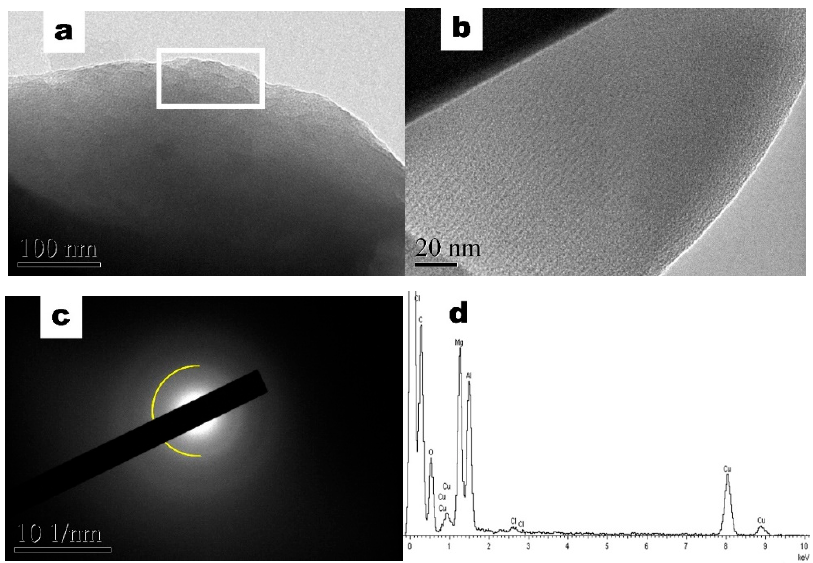
Figure 3. HR-TEM images of the as-prepared coating that is structured in nanolayers that overlap themselves ( a ), ( b ); ( c ) the SAED pattern showing weak rings from nanolayers; and ( d ) the EDS spectrum shows that the composition is mainly Mg and C (as the TEM grid is Cu and Cl are associated with the MgCl 2 reactant used).